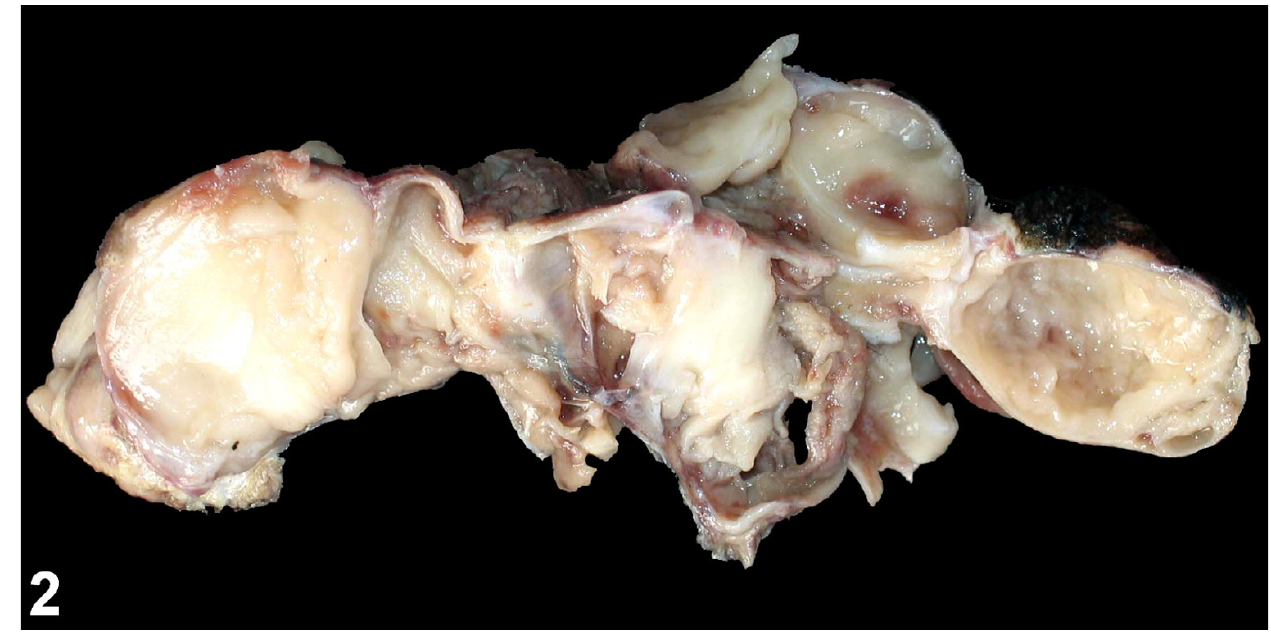
Gross specimen revealing glistening gelatinous gray-white cut surface with cystic areas